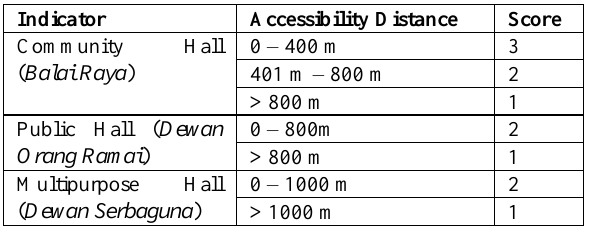
Table 2: The radius distance accessibility between residential